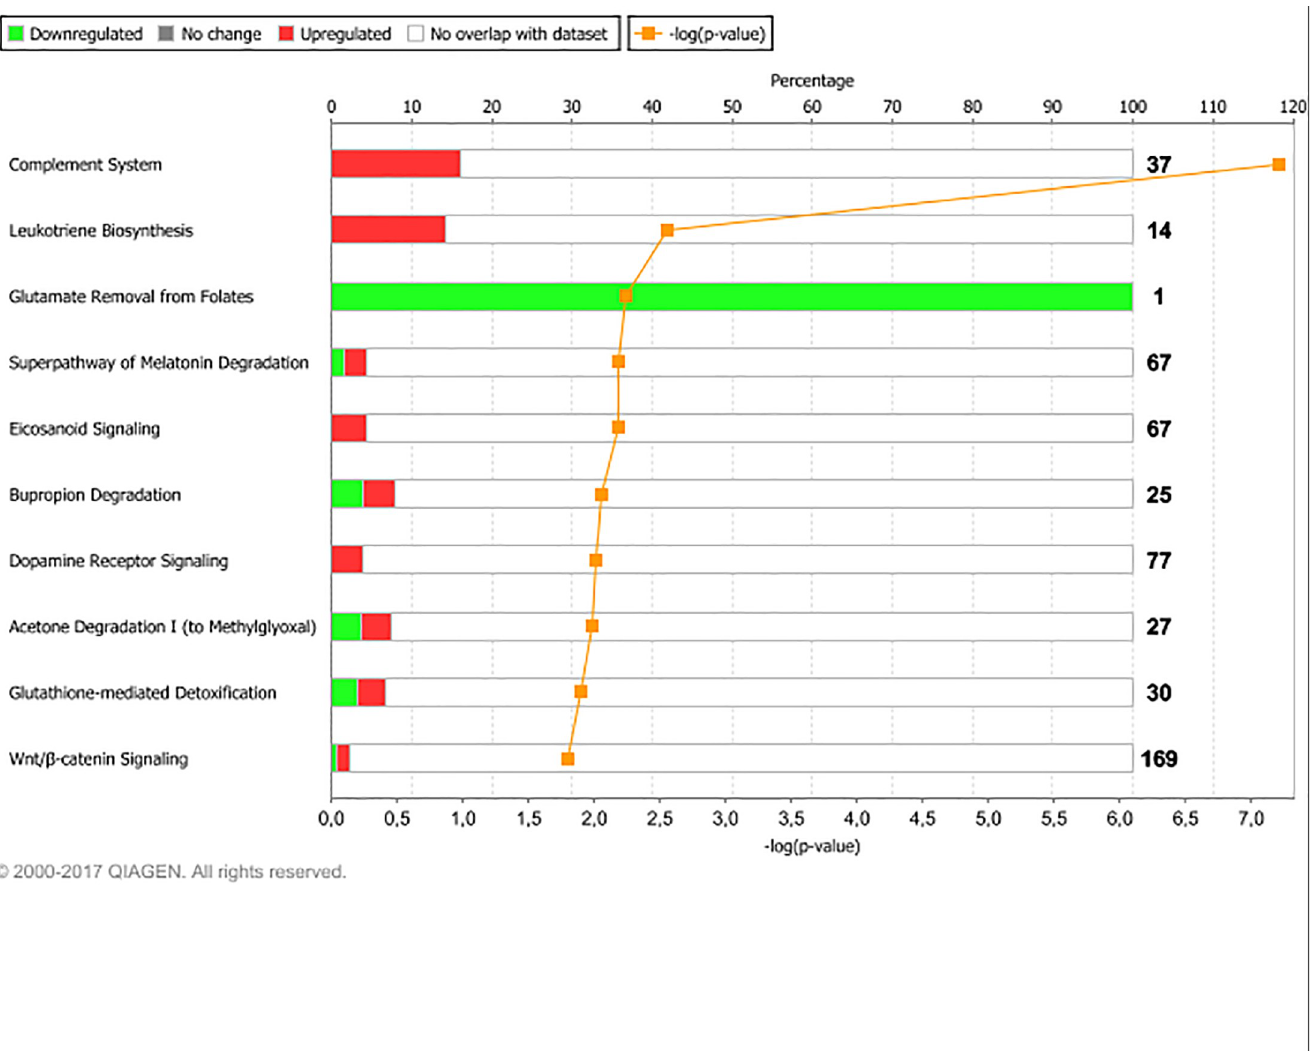
Fig 8. Main affected pathways common to all treatments during the period from 12MO to PREG. Main affected pathways associated with differentially expressed genes common to all heifers during development from experimental feeding at 12 months of age, to established similar feeding regimes at month 7 of gestation. Red bars indicate percent upregulated, and green bars indicate percent downregulated genes pertaining to the pathway during PREG versus 12MO. Number to the right of bars display total number of genes pertaining to each pathway. Orange squares indicate the negative logarithm of p-value of observation (-log p-value = 1.3 equals p- value = 0.05). (Reprinted from IPA under a CC BY license, with permission from Qiagen Bioinformatics, original copyright